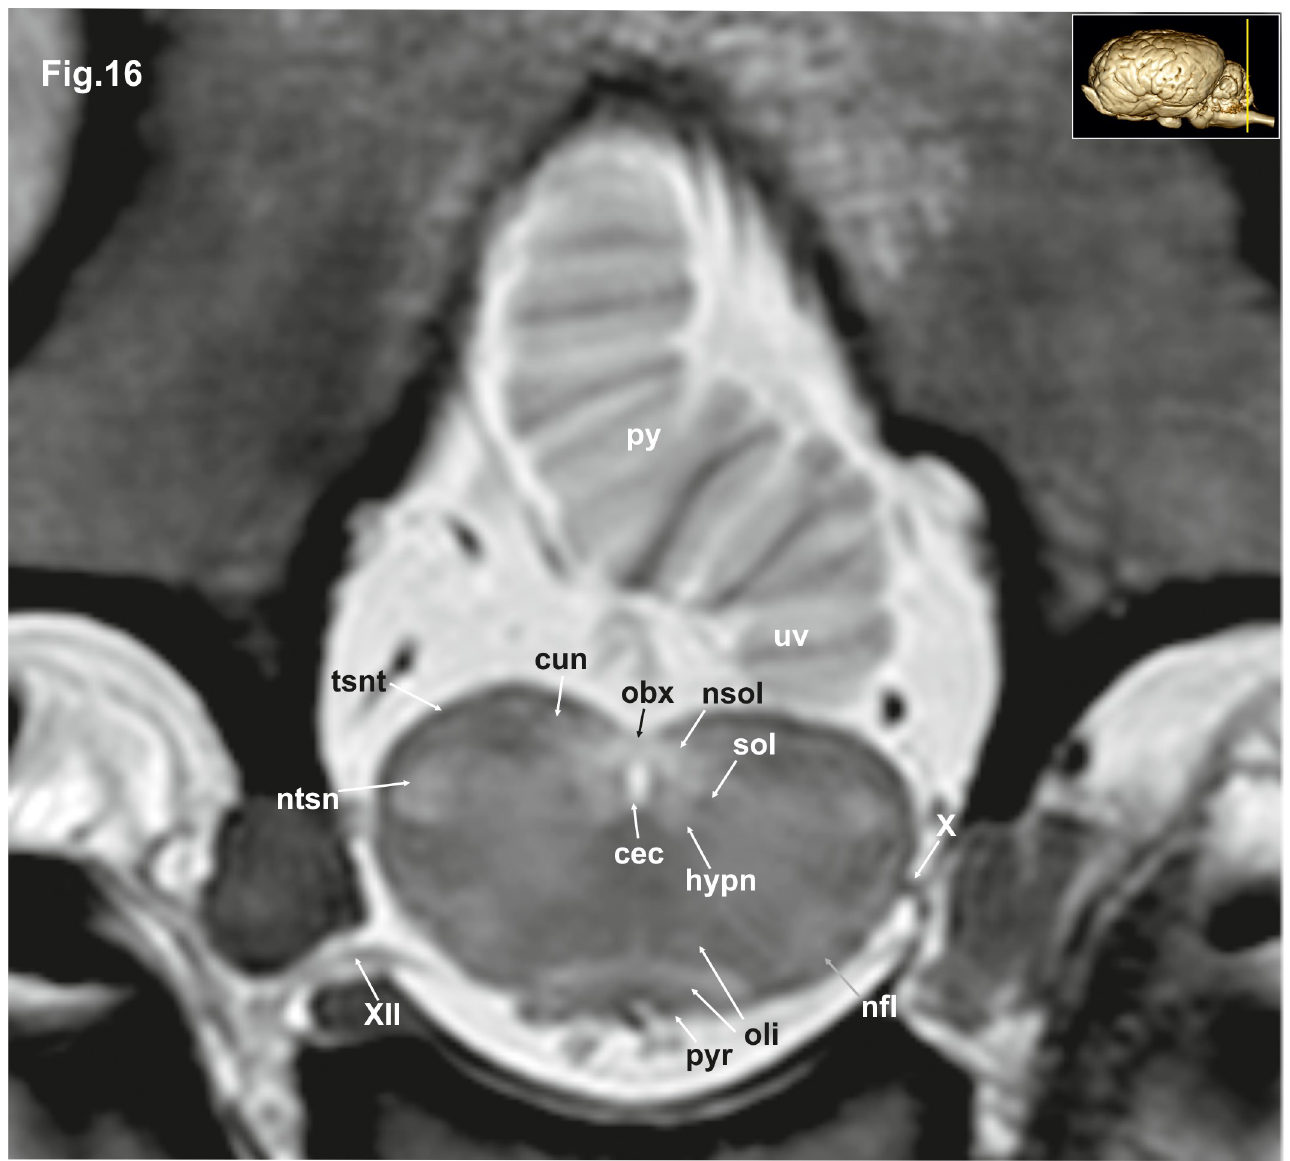
Fig 16. Transverse magnetic resonance image of the equine brain on the level of the obex. cun: cuneate nucleus, hypn: nucleus of the hypoglossal nerve, nfl: nucleus of the lateral fascicle, ntsn: nucleus of the spinal tract of the trigeminal nerve, oli: olivary nucleus, py: pyramis of the vermis, pyr: pyramidal tract, sol: solitary tract, tsnt: spinal tract of the trigeminal nerve, uv: uvula of the vermis, vgn: nucleus of the vagus nerve, X: vagus nerve, XII: hypoglossal nerve. Stripes of grey matter connect the head of the caudate nucleus and the putamen. Further caudally, the putamen quickly increases in height and width but never attains the dimensions of the caudate nucleus. The rostral part of the putamen appears on transverse sections as a rather narrow straight band of grey matter stretching from dorso-lateral to ventro-medial. The middle part, the largest, is triangular in shape on the transverse sections. The putamen is lat- erally bordered by a thin layer of hypointense white matter, the external capsule (Capsula externa; Figs 4–7, 22 and 32; S2–S6 Figs: ec). A hypointense fiber bundle can be seen ventrolat- eral to the globus pallidus running into the caudal limb of the internal capsule. This is the ansa